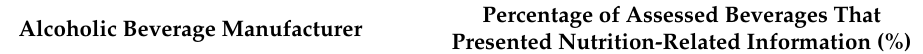
Table 4. Proportion of alcoholic beverages that present nutrition-related information, of those manufactured by manufacturers with five or more beverages included in the